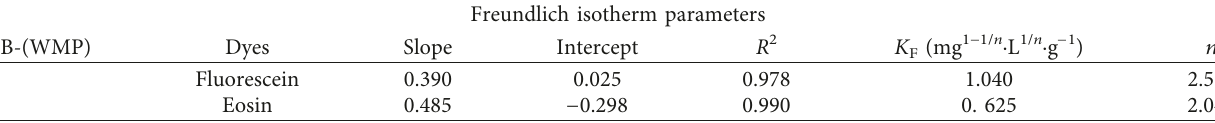
Table 8: Freundlich isotherm parameters of the B-(WMP) sorbent. Freundlich isotherm parameters